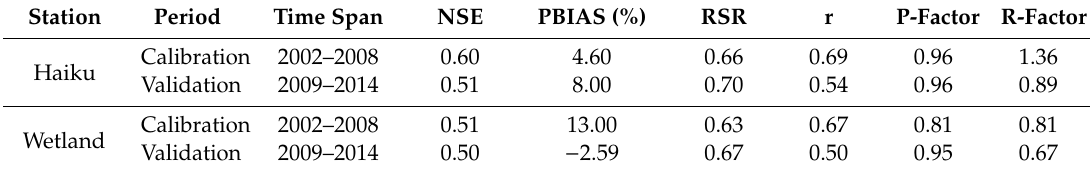
Table 3. Goodness-of-fit statistics of the Heeia watershed at Haiku and Wetland